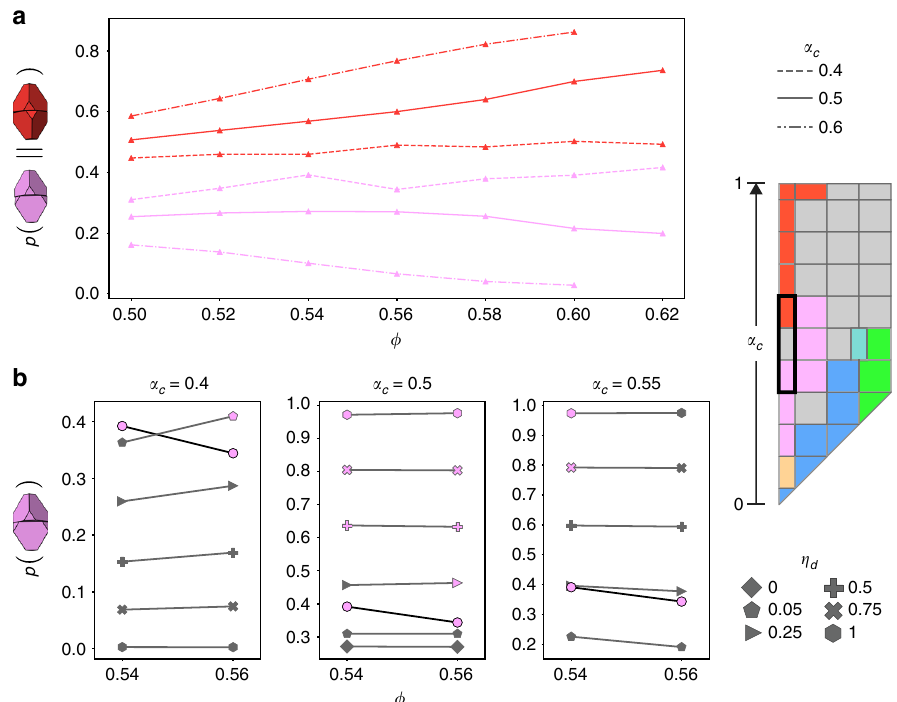
Fig. 4 Tuning of local structure in disordered and crystal-forming fl uids. Disordered and crystal-forming fl uids are structurally different, and tuning their fl uid structure can promote or suppress crystallization. Systems are identi fi ed by α c , indicating their location in shape space at ( α a , α c ) = (0, α c ), and the relevant location in shape space is outlined in black in the image to the right of the plots. a Twisted and aligned motif fractions, or probabilities of observing either motif, as a function of packing fraction for the disordered system at ( α a , α c ) = (0, 0.5) and nearby crystal-formers. Pink triangles represent twisted motif fractions, and red triangles represent aligned motif fractions. Different line styles indicate different locations in shape space. Crystal-forming fl uids contain higher fractions of the motifs that dominate in the assembled structures. b Doping via the introduction of rigid local structural motifs into dense fl uids in fl uences assembly behavior, causing crystallization for systems that might otherwise vitrify, and vitri fi cation for systems that otherwise crystallize. Panels show twisted motif fraction, or the probability of observing the twisted motif, for (pre-cursor) fl uids during doping experiments at different locations in shape space. Symbols indicate different dopant fractions η d . The dopant dimer is the twisted motif for α c = 0.5 and α c = 0.55, in which case doping promotes self-assembly into the diamond structure. For α c = 0.4, the dopant dimer is the aligned motif, in which case doping disrupts self-assembly into the diamond structure. Symbols are colored pink if the system self-assembles into diamond on the time scales of our simulations. The threshold for assembly established by the undoped system at ( α a , α c ) = (0, 0.4) is indicated by circles connected by a black line. In all panels, error bars are smaller than the symbols, and are calculated in a manner detailed in the Precursor fl uid identi fi cation section of the